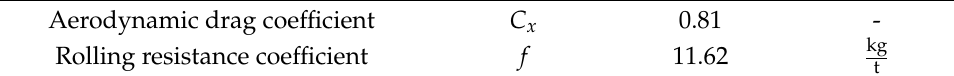
Table 11. Aerodynamic and rolling resistance coefficient values of two-wheeler road load